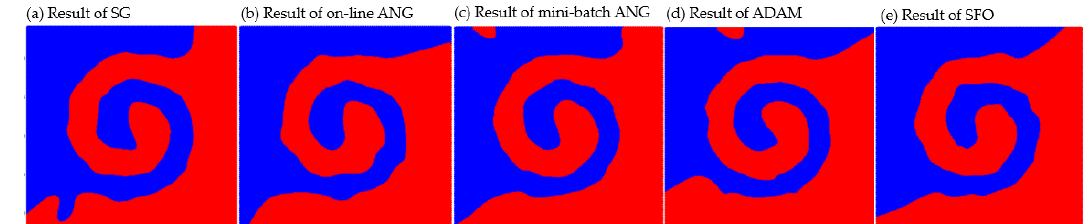
Figure 7. Obtained decision boundary by ( a ) standard gradient (SG), ( b ) online adaptive natural gradient (ANG), ( c ) proposed mini-batch ANG, ( d ) Adam optimizer, and ( e ) sum of functions optimizer (SFO).